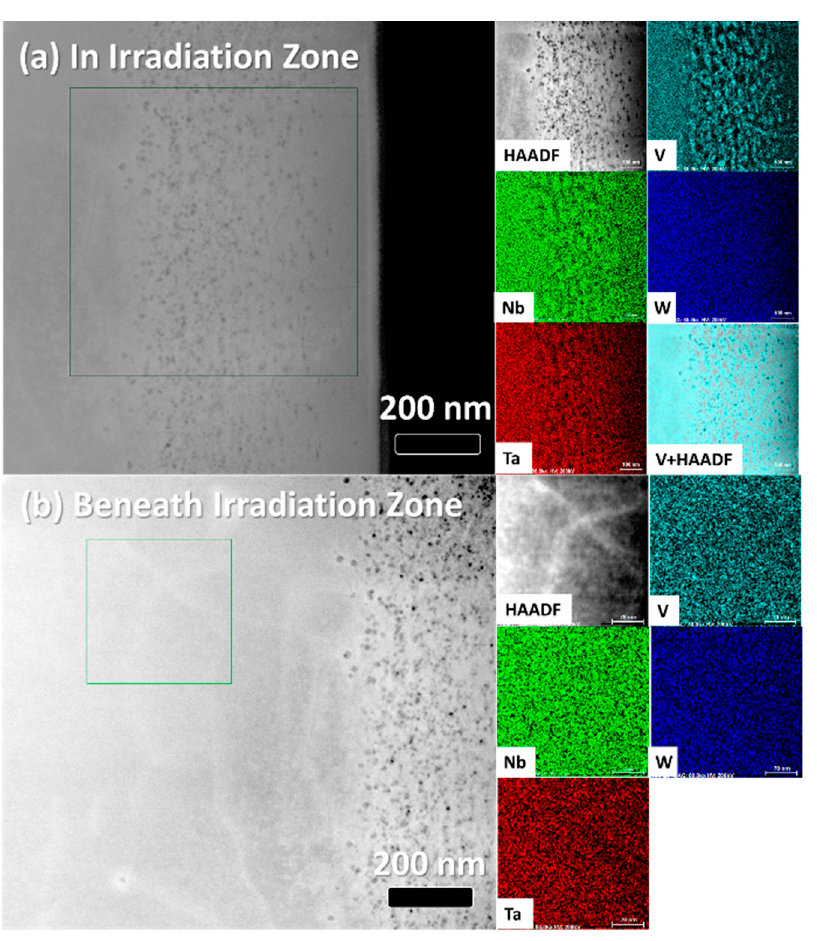
Figure 3. STEM-HAADF micrographs and associated STEM-EDS elemental maps of the NbTaVW sample showing V segregation in the He-irradiated region ( a ), but not in the bulk sample ( b ). Green boxes in the large HAADF micrographs indicate the regions of EDS elemental mapping.